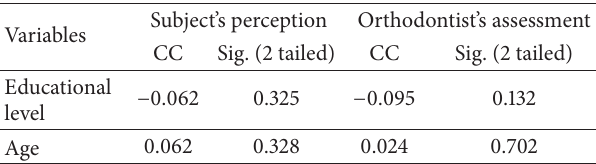
Table 3: Correlation between subject’s perception and orthodon- tist’s assessment with educational level and age.